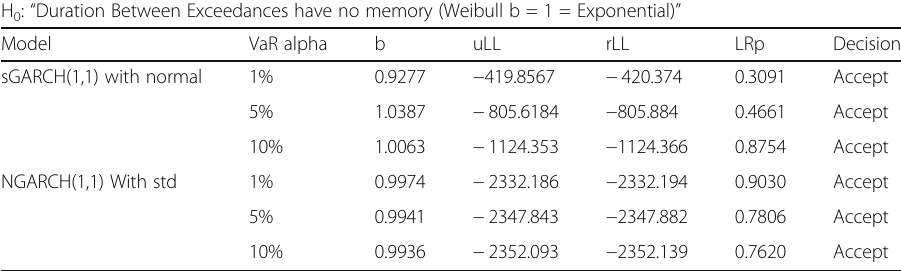
Table 10 Implements the VaR Duration Test of Christoffersen and Pelletier on Cleansed Total Nigeria Plc returns H 0 : “ Duration Between Exceedances have no memory (Weibull b = 1 = Exponential) ” Model VaR alpha b uLL rLL LRp Decision sGARCH(1,1) with normal 1%